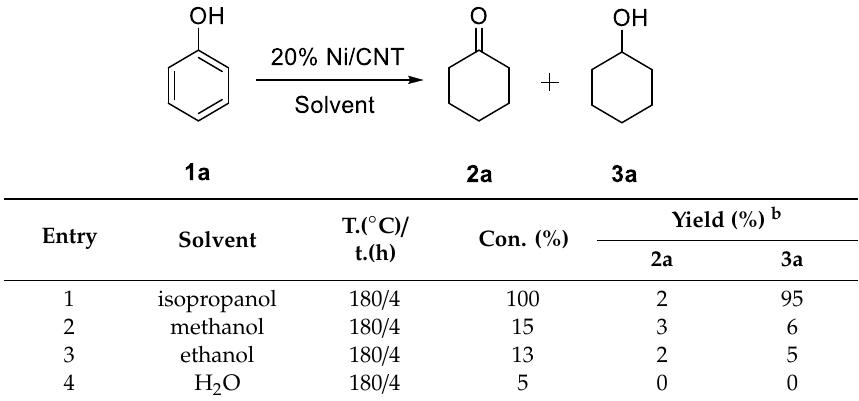
Table 3. Optimization of solvents for the hydrogenation of phenol a .